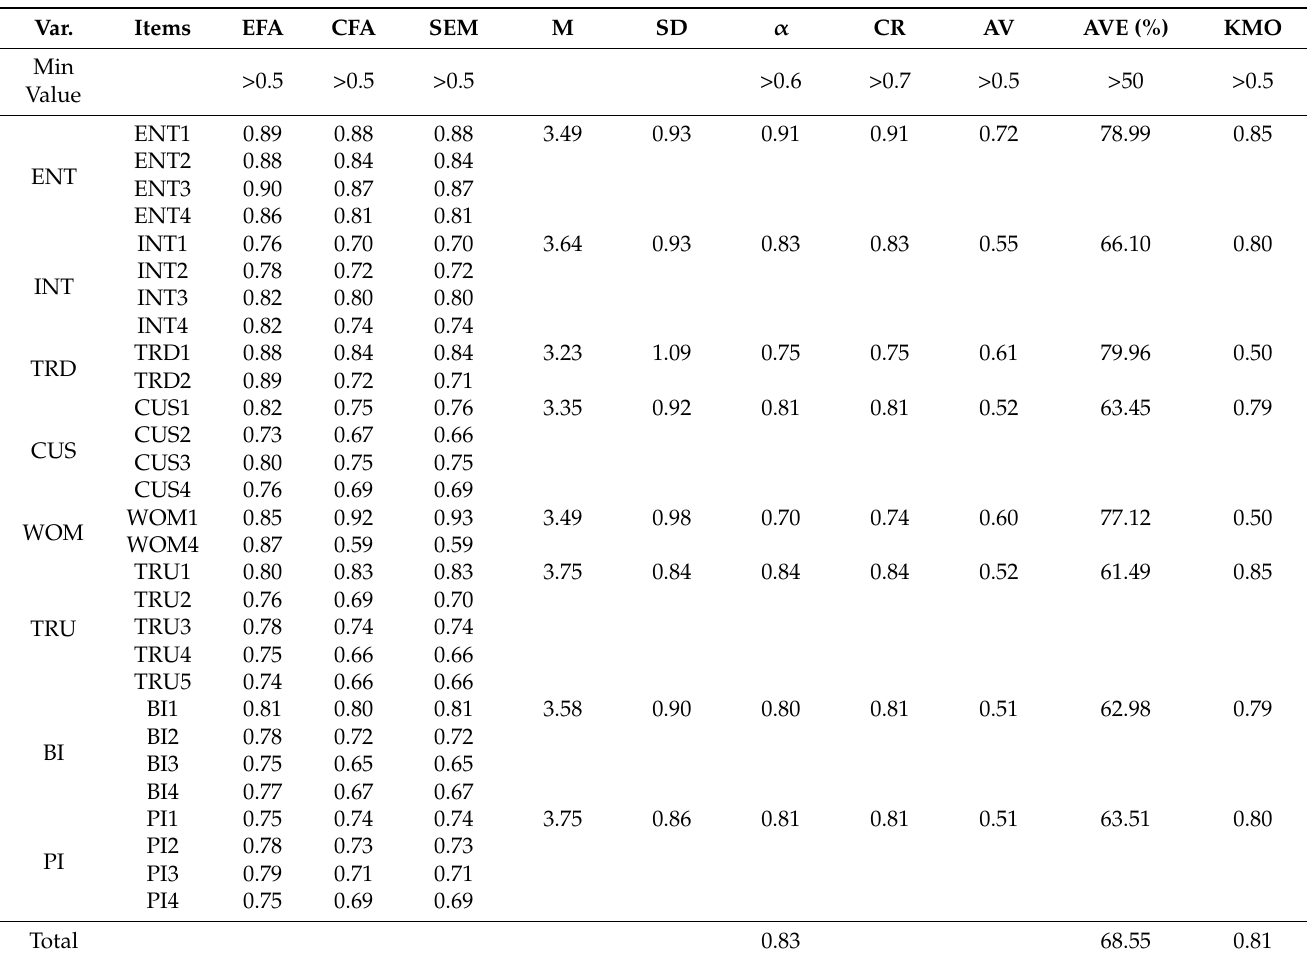
Table 3. Summary of reliability and